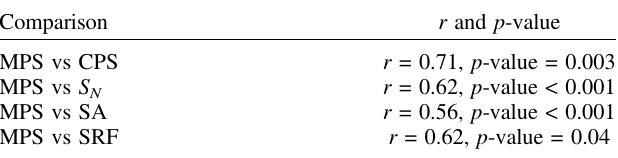
Table 3. Correlation coef fi cients between the homogenized series of the Madrid prominence number presented in this work and Coimbra prominence series, sunspot number, sunspot area, and solar radio fl ux at 10.7